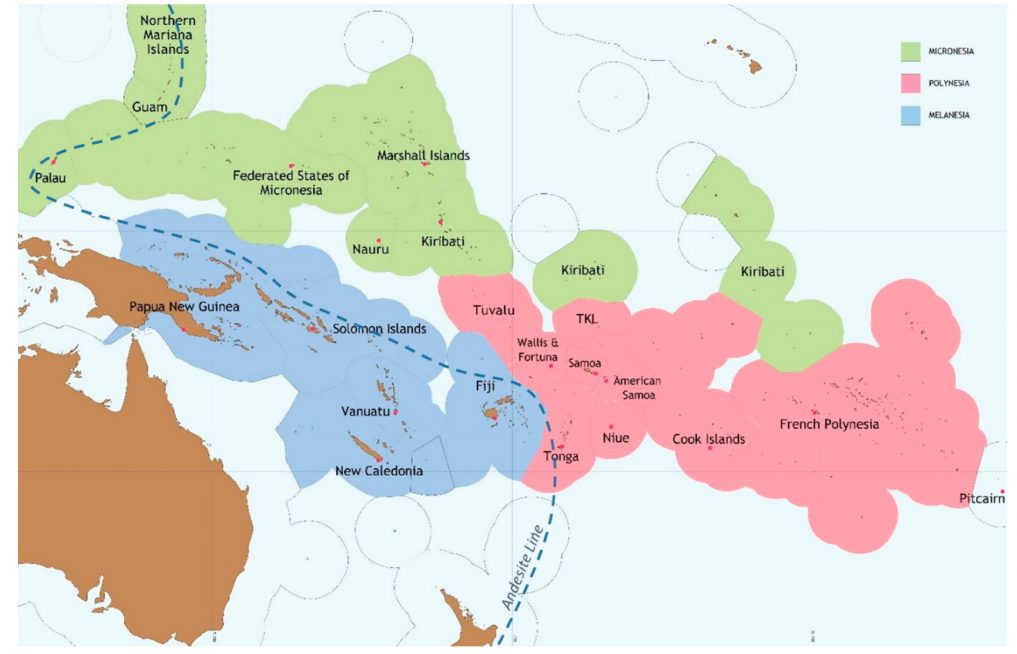
Figure 1. Map of Pacific Islands’ countries and